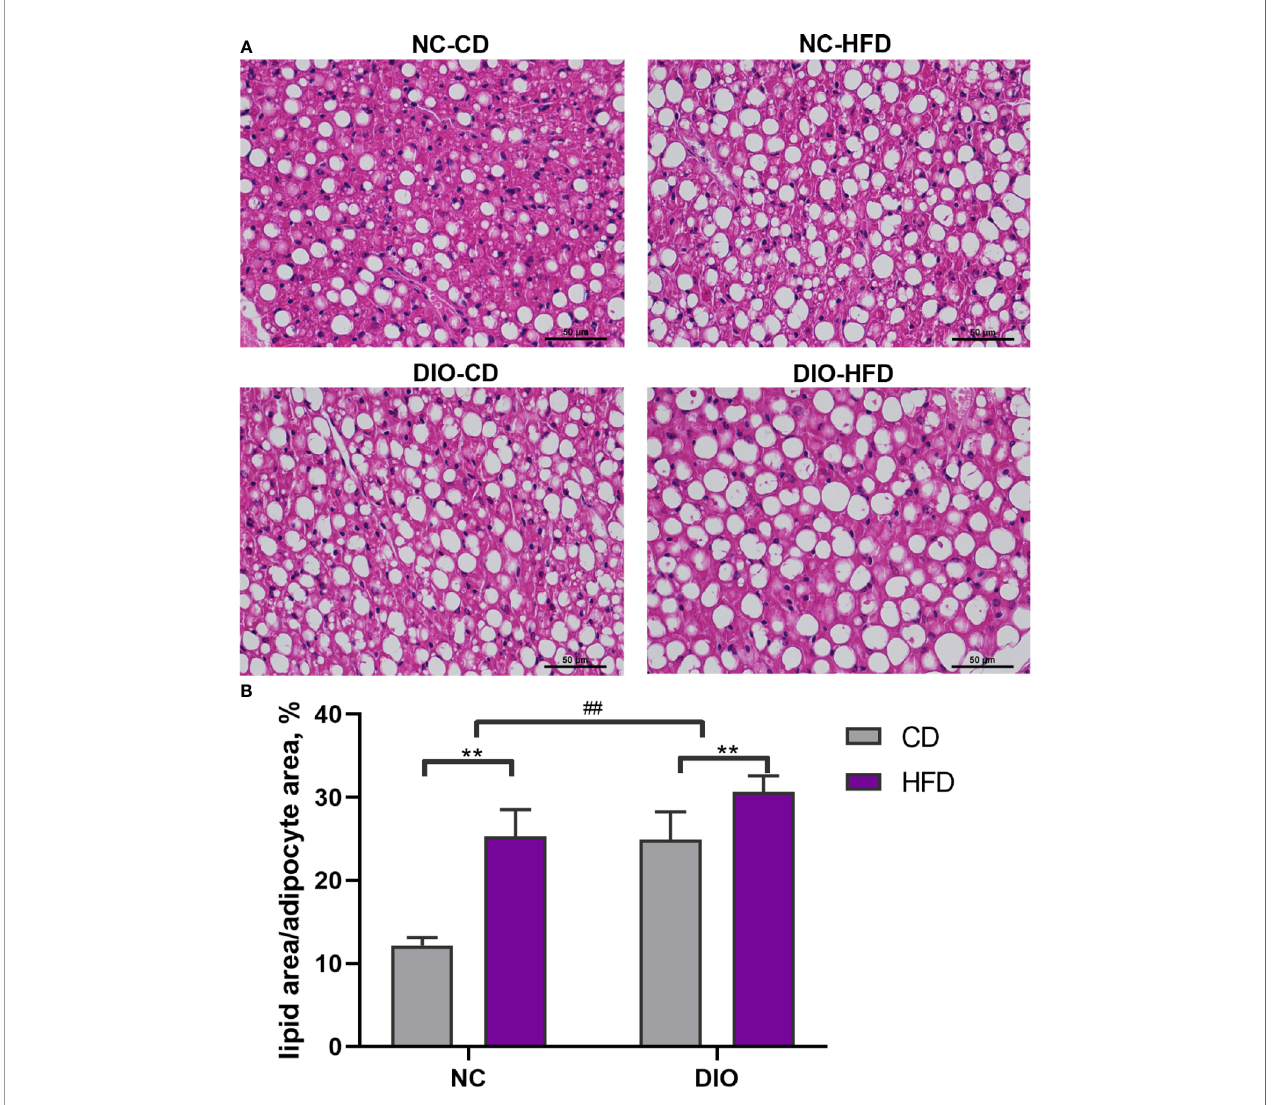
FIGURE 4 | The effect of maternal HFD disrupts the morphology of brown adipose tissue (BAT) in male offspring. (A) H&E staining (magni fi cation 400 x), (B) lipid area analysis (lipid area/total adipocyte area, %) of BAT (n = 8 for each group). Values represent the mean ± SEM, n = 8 each group. P values represent signi fi cance in the main effect for each source of variation (diet or prenatal exposure) as calculated by two-way ANOVA: ** P < 0.01 offspring diet effect, ## P < 0.01 maternal diet effect. NC, normal control; DIO, diet-induced obesity; CD, control diet; HFD, high-fat